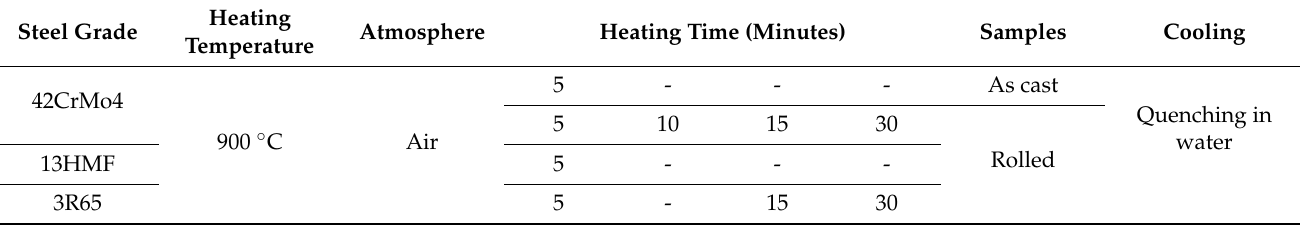
Table 2. Heat treatment parameters for different steel